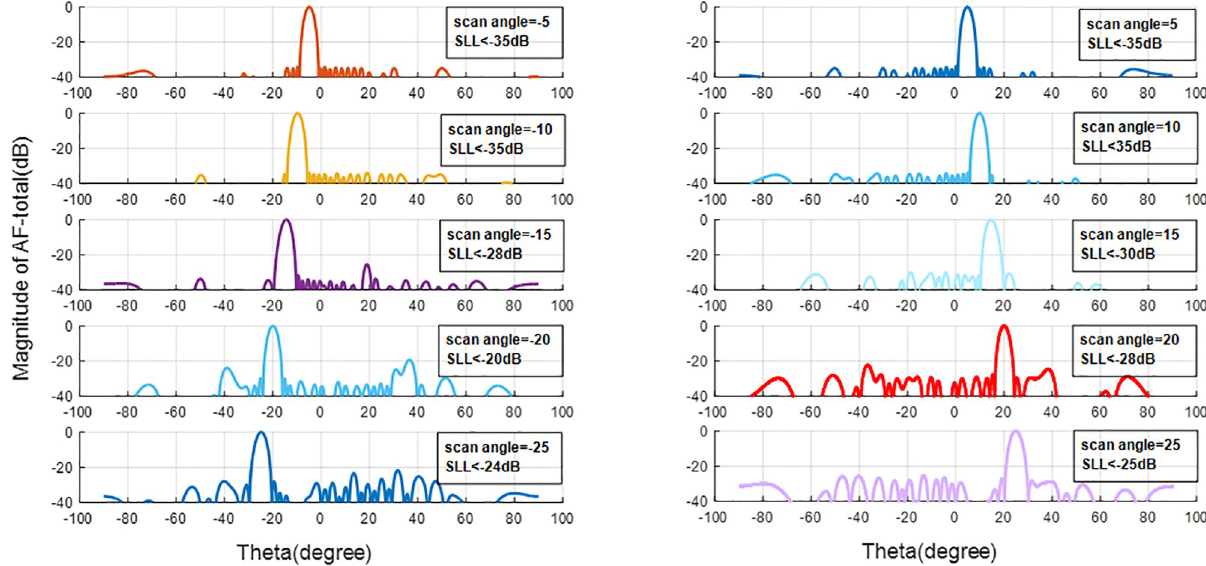
Fig 4. Normalized radiation patterns with GAPSO amplitude and phase tapering for ± 25˚ scan for aperiodic array in 28 GHz.